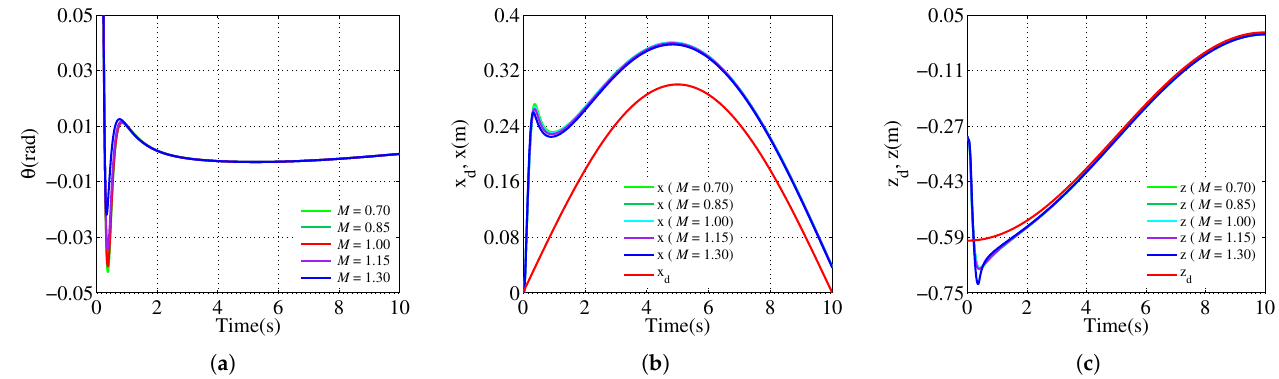
Figure 9. The simulation tests when M = 0.70,0.85,1.00,1.15, and 1.30. ( a ) The θ ; ( b ) the x d and x ; and ( c ) the z d and z .